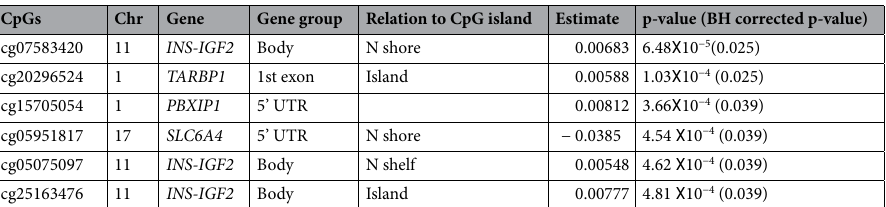
Table 3. Association between prenatal exposure to sulfur dioxide during the 3rd trimester (per IQR increase) and DNAm at ADHD associated CpGs at 2 years of age* (FDR corrected p-value < 0.05) (n = 51). IQR , interquartile range, FDR false discovery rate, ADHD attention-deficit hyperactivity disorder. *Adjusted for mother’s age, education level, maternal smoking, maternal environmental tobacco smoking, and season of birth.